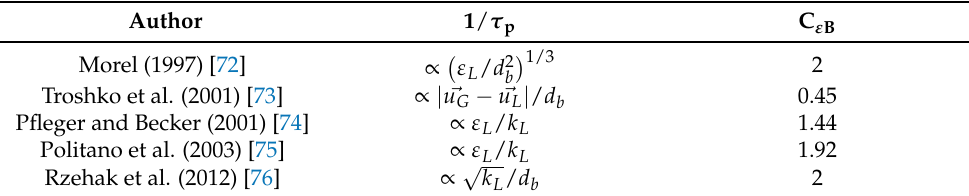
Table 4. Time scale factors commonly used in numerical simulation of bubble